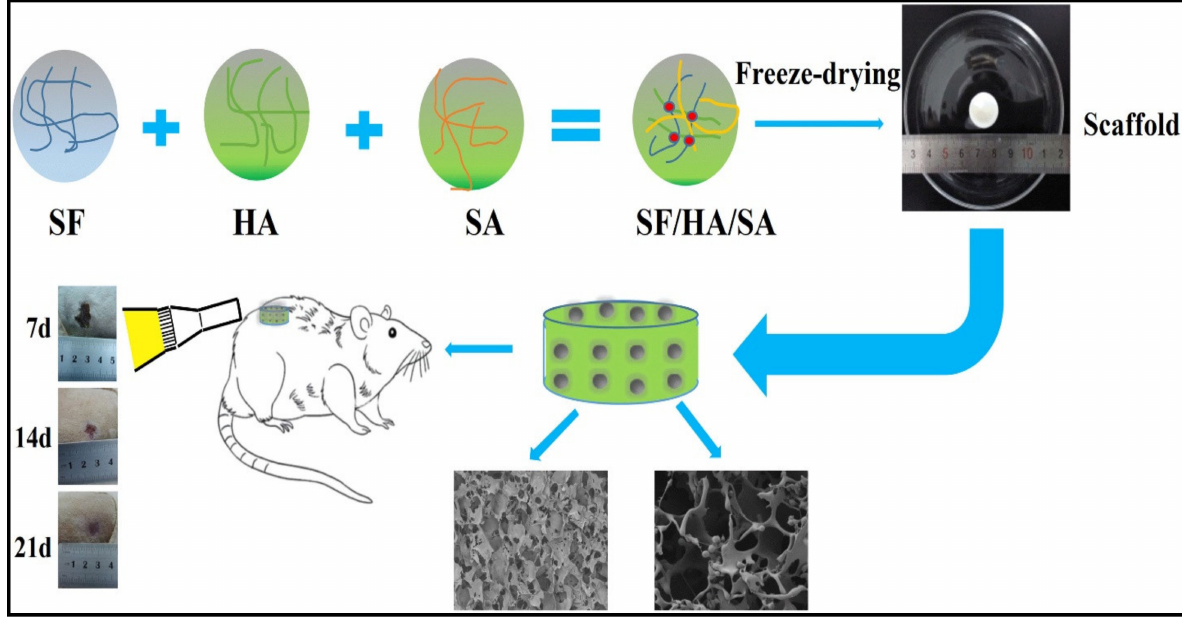
Figure 5. Schematic illustration of silk fibroin (SF), hyaluronic acid (HA), and sodium alginate (SA) composite scaffold for wound dressing and skin regeneration applied on an animal full-thickness burn model. Adapted with permission from ref. [130]. 2019